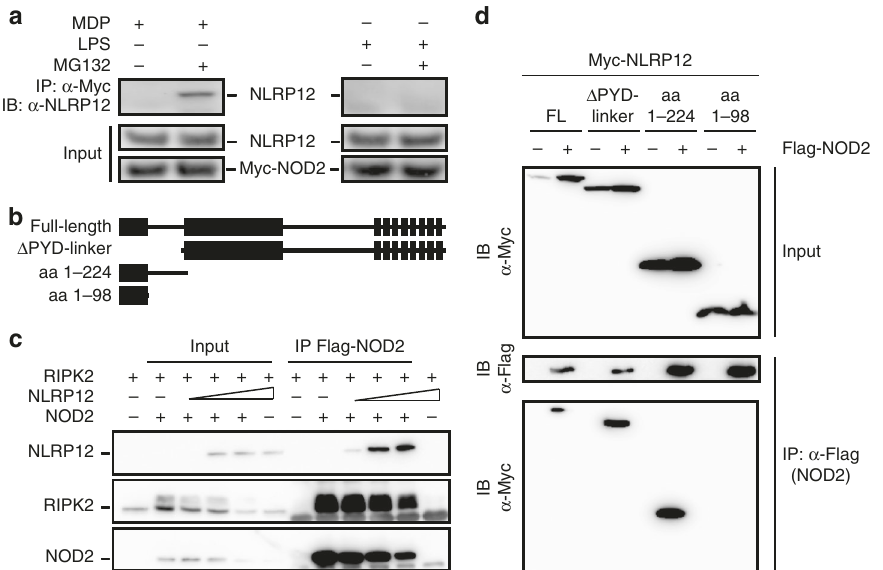
Fig. 1 NLRP12 interacts with NOD2 through a linker-region proximal to the nucleotide-binding domain. a Co-immunoprecipitation with anti-Myc (top panel) and lysates (bottom panel) of the THP-1 Myc-BirA*-NOD2 stable cell line that were treated with muramyl dipeptide (MDP at 10 µ g/mL) or lipopolysaccharide (LPS at 0.2 µ g/mL) for two h. b Scheme of Myc-tagged constructs encoding human wild-type NLRP12 and mutated NLRP12 proteins Δ